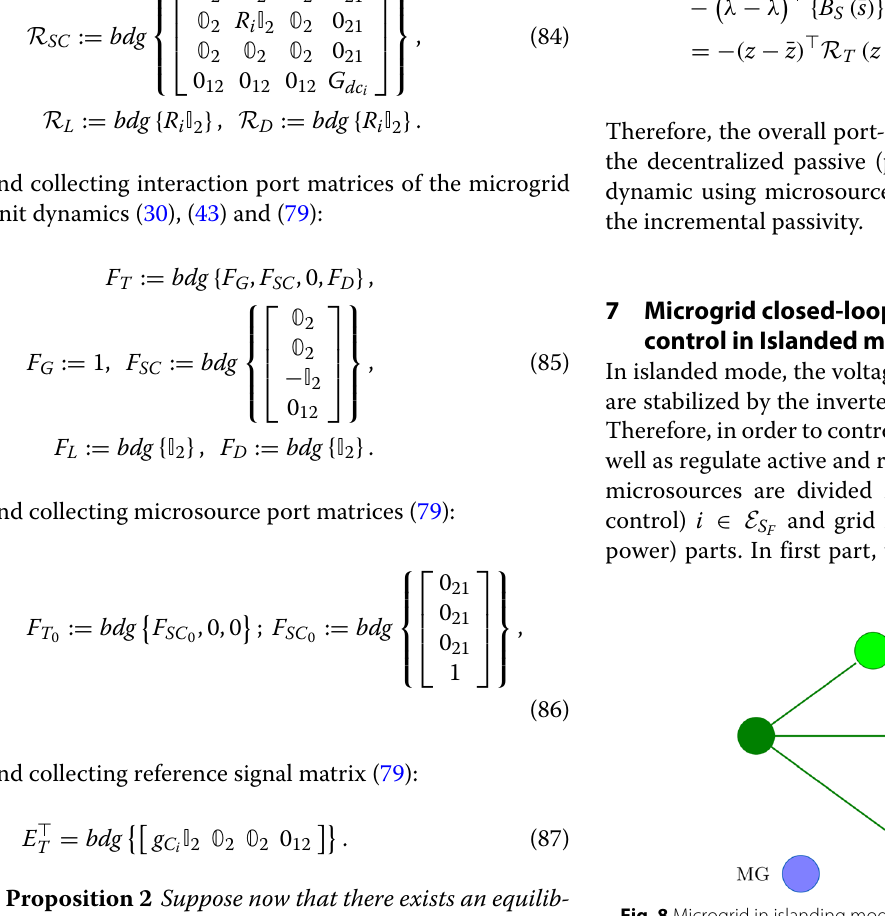
Fig. 8 Microgrid in islanding